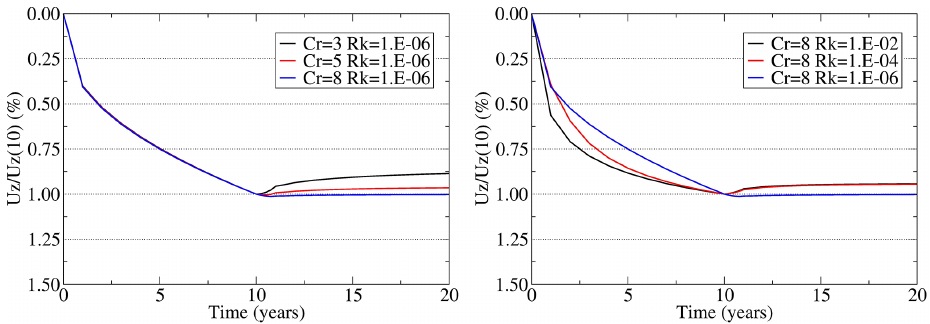
Figure 3. Maximum vertical displacement U z normalized with respect to the displacement at the end of the pumping period (10 years) U z (10) in the case with H a = 500m and (cid:49)S s = 10m. In the left panel R k = 1 × 10 − 6 and C r = 3, 5 and 8. In the right panel C r = 8 and R k = 1 × 10 − 2 , 1 × 10 − 4 and 1 × 10 − 6 .